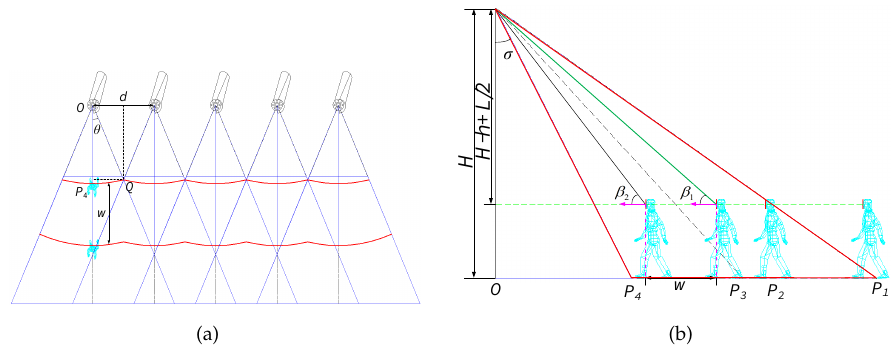
Figure 5. ( a ) The vertical view of barrier coverage; ( b ) The lateral view of barrier